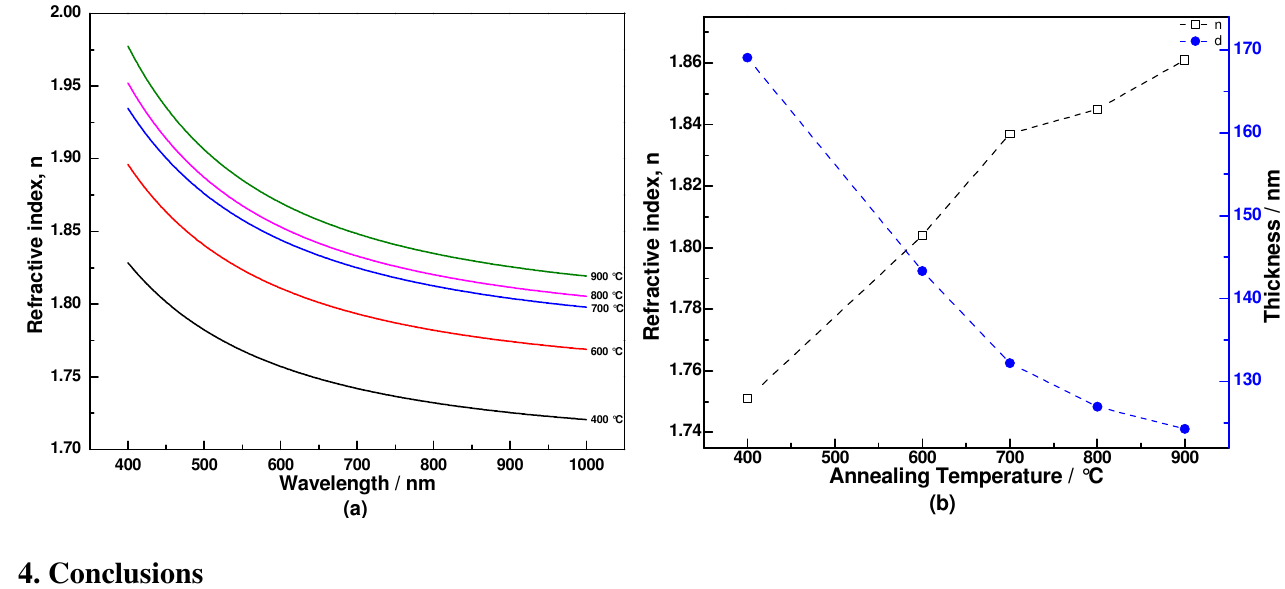
Figure 5. ( a ) Refractive index dispersion of binary coatings annealed at various temperatures; ( b ) Variation of refractive index (at 633 nm) and thickness of coatings annealed at various